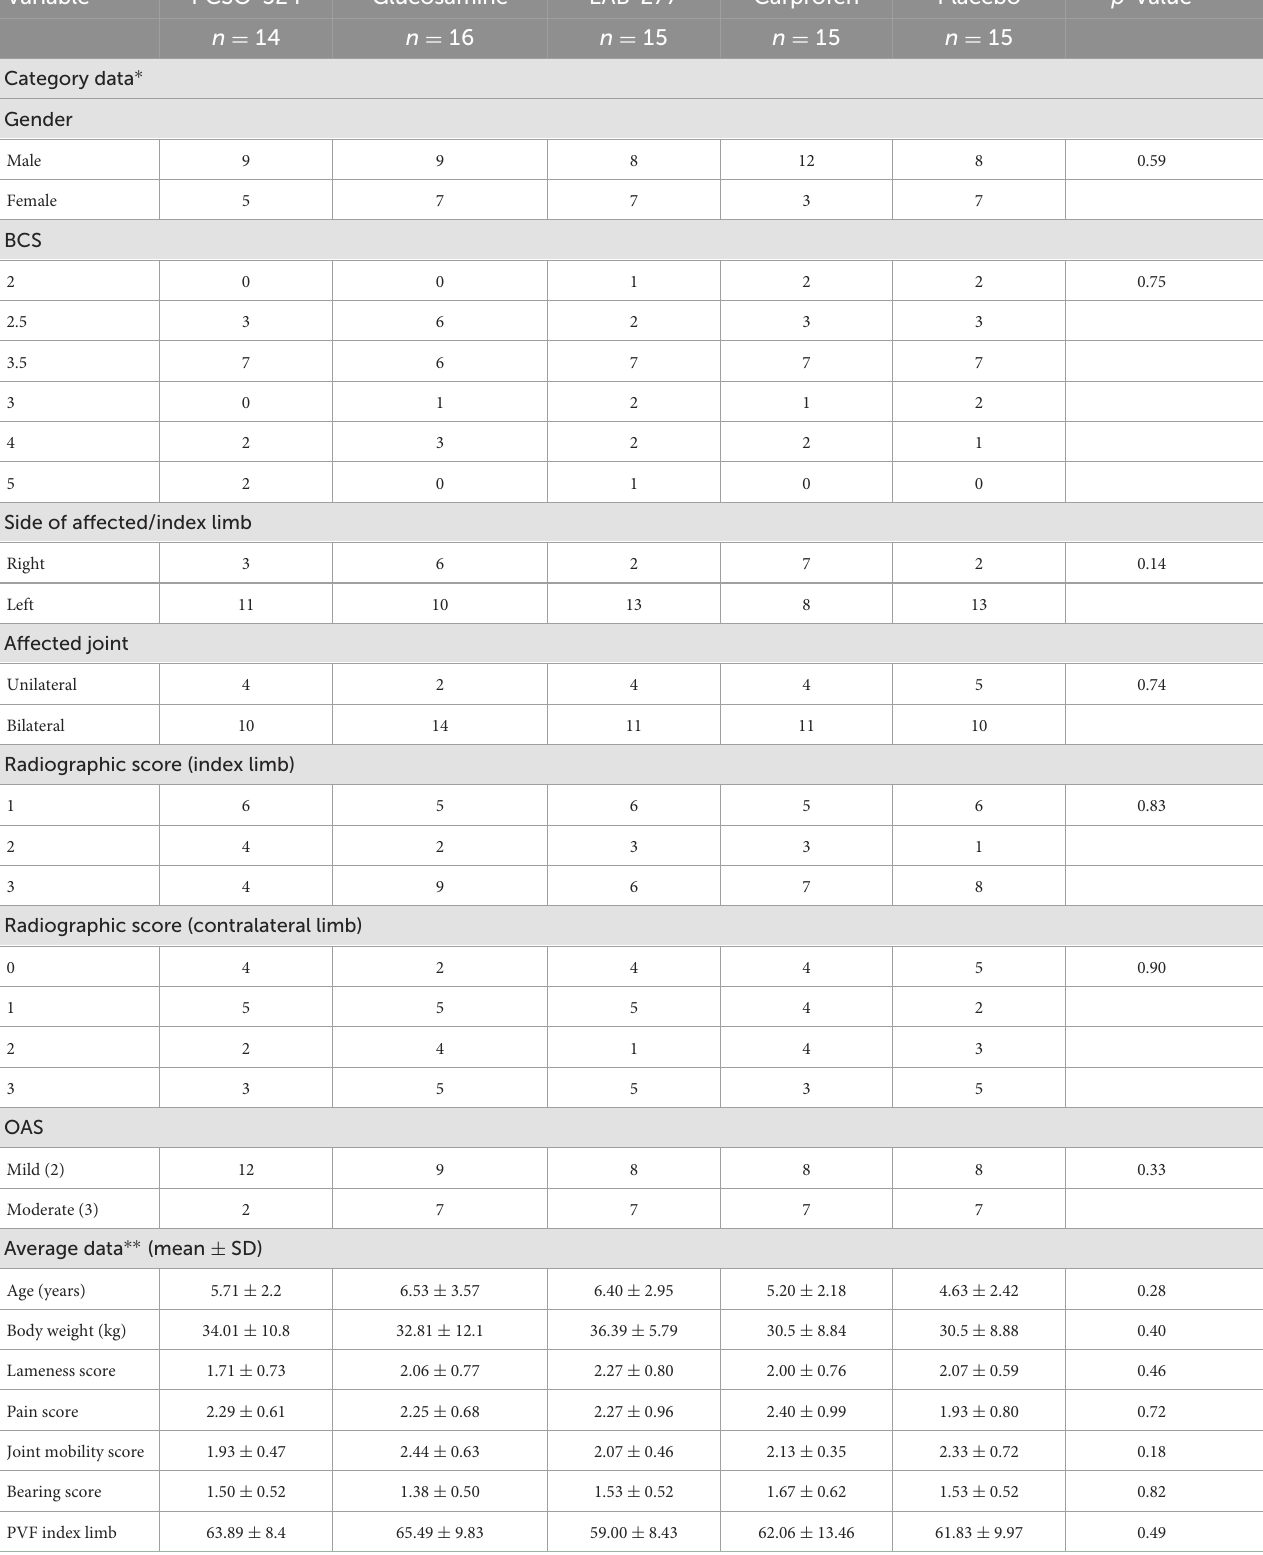
TABLE 4 Demographic data and variables at the first visit (week